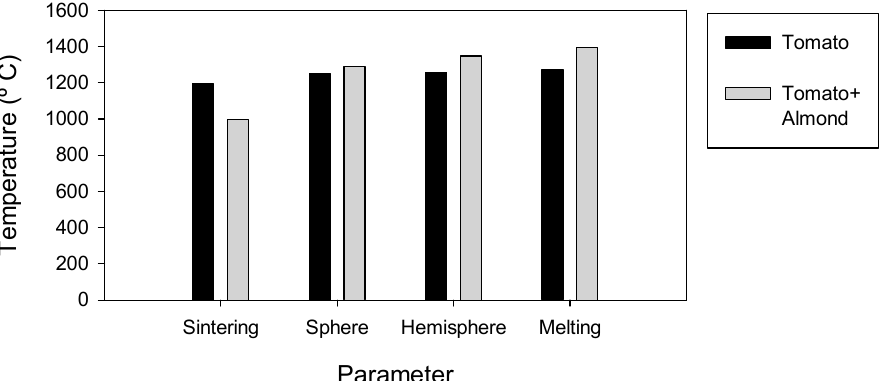
Figure 2. Elemental composition of the tomato-crop biomass, and the blend of this with almond prunings.